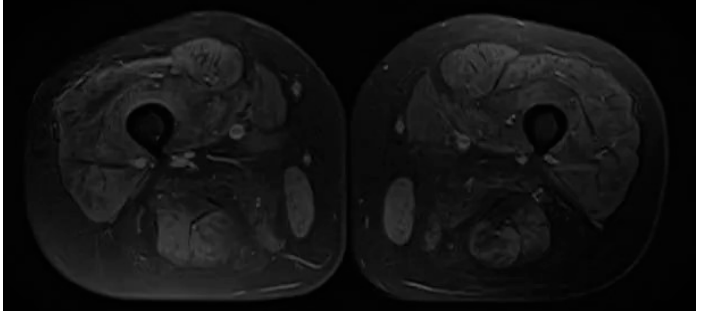
Figure 3. Axial fat-saturated proton density-weighted MRI scan with diffuse decrease of signal intensity from all muscles of the both shins.